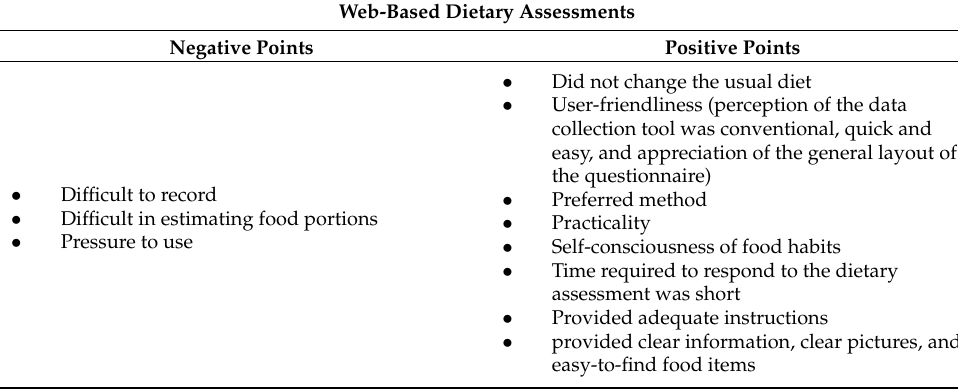
Table 4. Summary of usability of the web-based dietary assessment